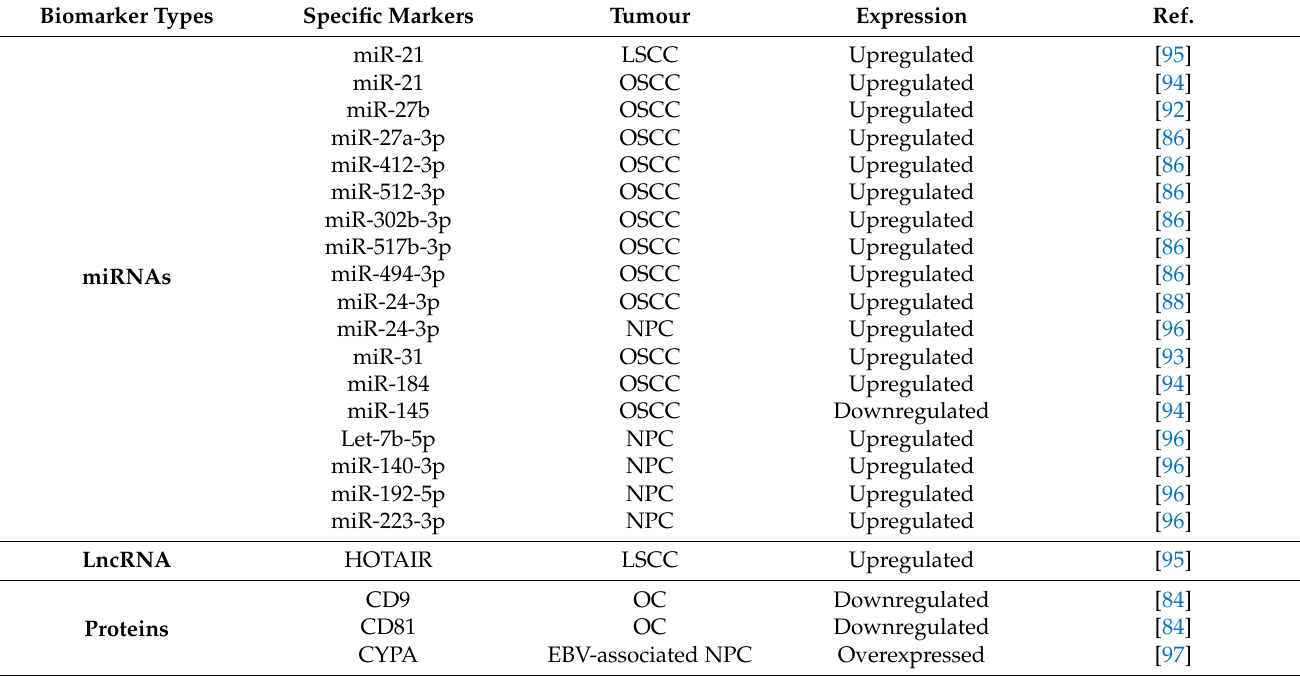
Table 4. EVs as potential biomarkers in head and neck